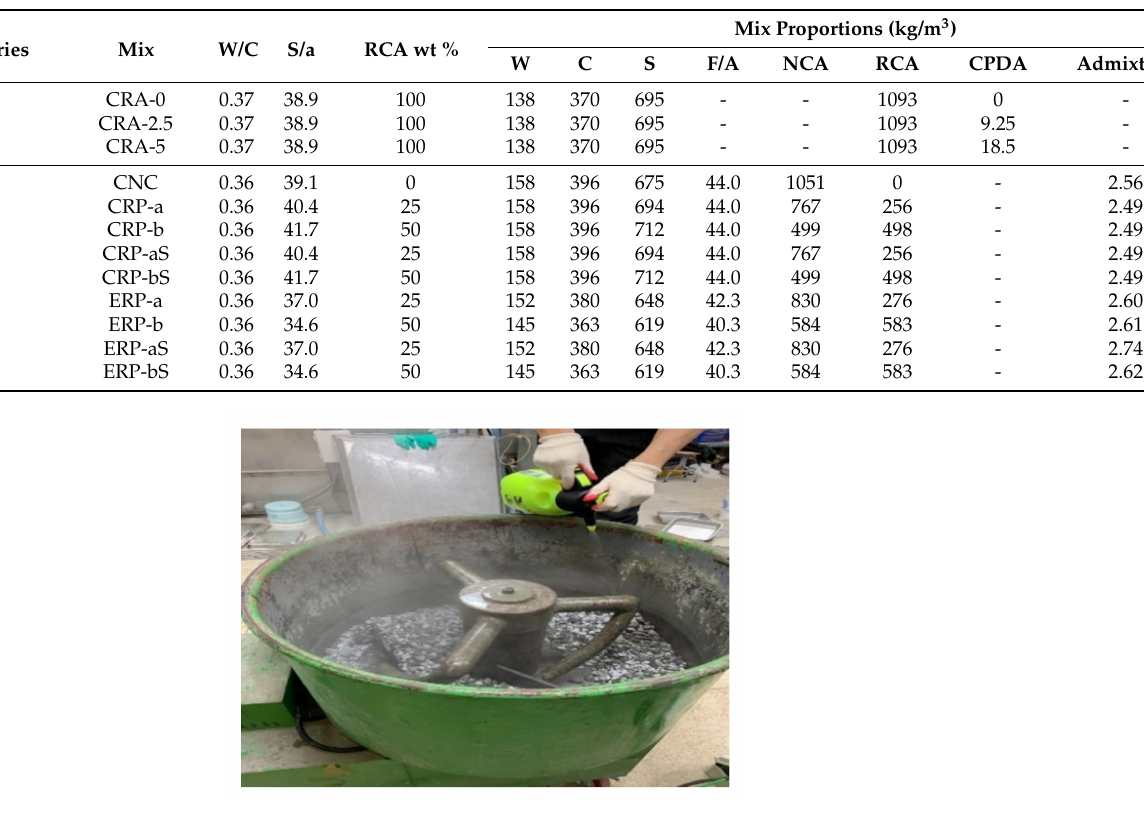
Figure 3. Spray coating